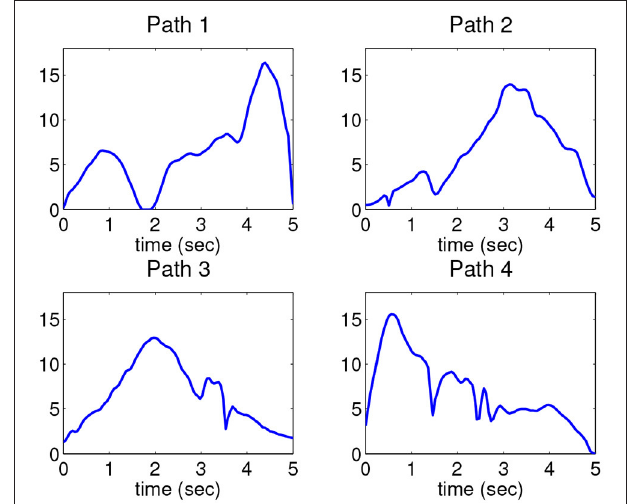
FIGURE 7 | Estimated intensity function in each